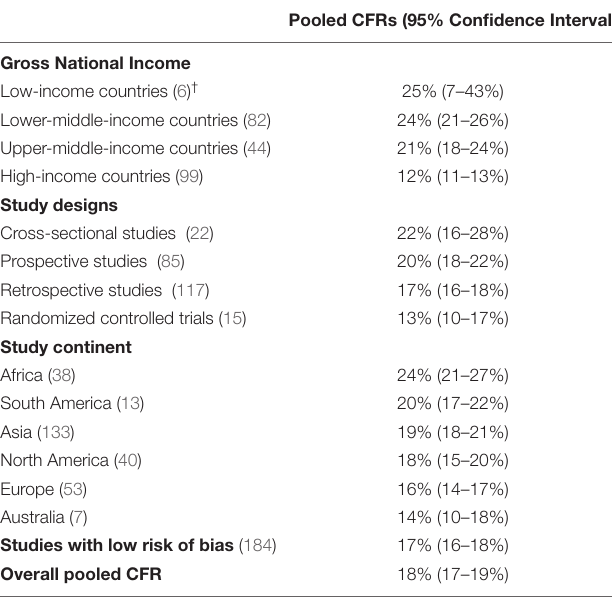
TABLE 3 | Pooled Case Fatality Rates based on study characteristics.